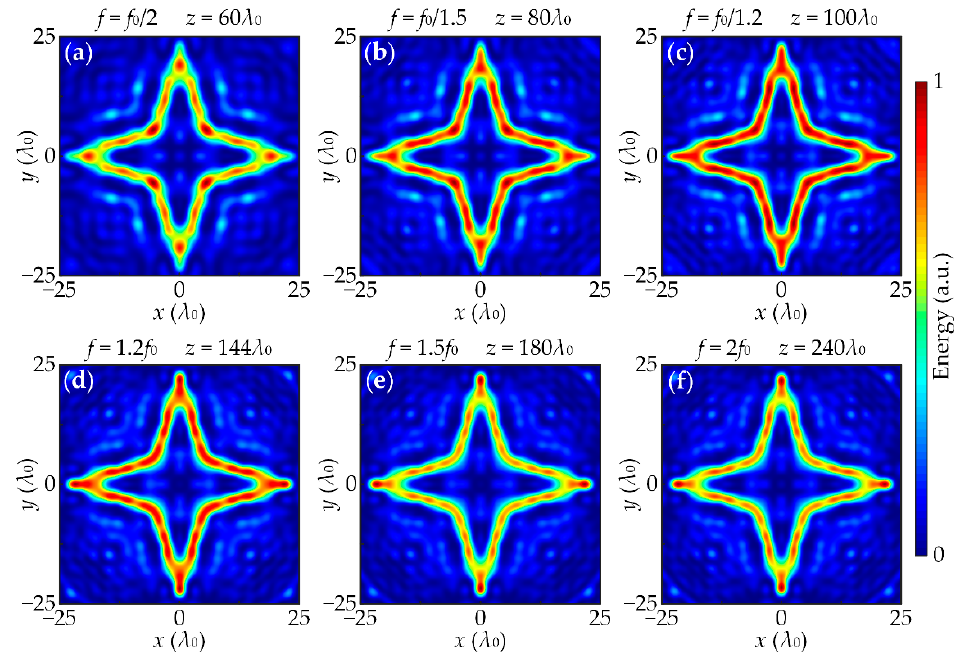
Figure 5. Acoustic broadband holographic imaging. ( a – f ) The normalized sound energy distributions in the image planes of the ASM-based hologram are calculated using the numerical simulation when the incident frequencies ( f ) are f 0 /2, f 0 /1.5, f 0 /1.2, 1.2 f 0 , 1.5 f 0, and 2 f 0 , respectively. The imaging distances ( z ) are 60 λ 0 , 80 λ 0 , 100 λ 0 , 144 λ 0 , 180 λ 0 , and 240 λ 0 , respectively.